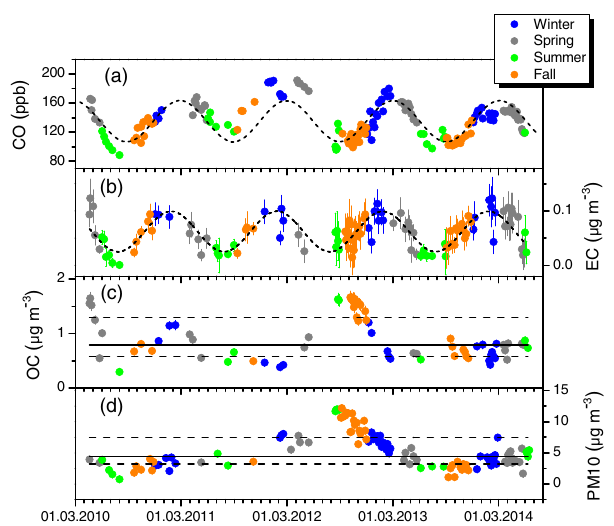
Figure 11. Time series of CO (a) , EC (b) , OC (c) , and PM 10 (d) background concentrations for 300m at ZOTTO. Fit lines: (a, b) sine fit with time period of 365 ± 4 days and coefficient of deter- mination, with R 2 = 0.60 and 0.58, respectively; (c, d) median – black solid; 75 and 25th percentiles – dashed line. Different colours represent the different